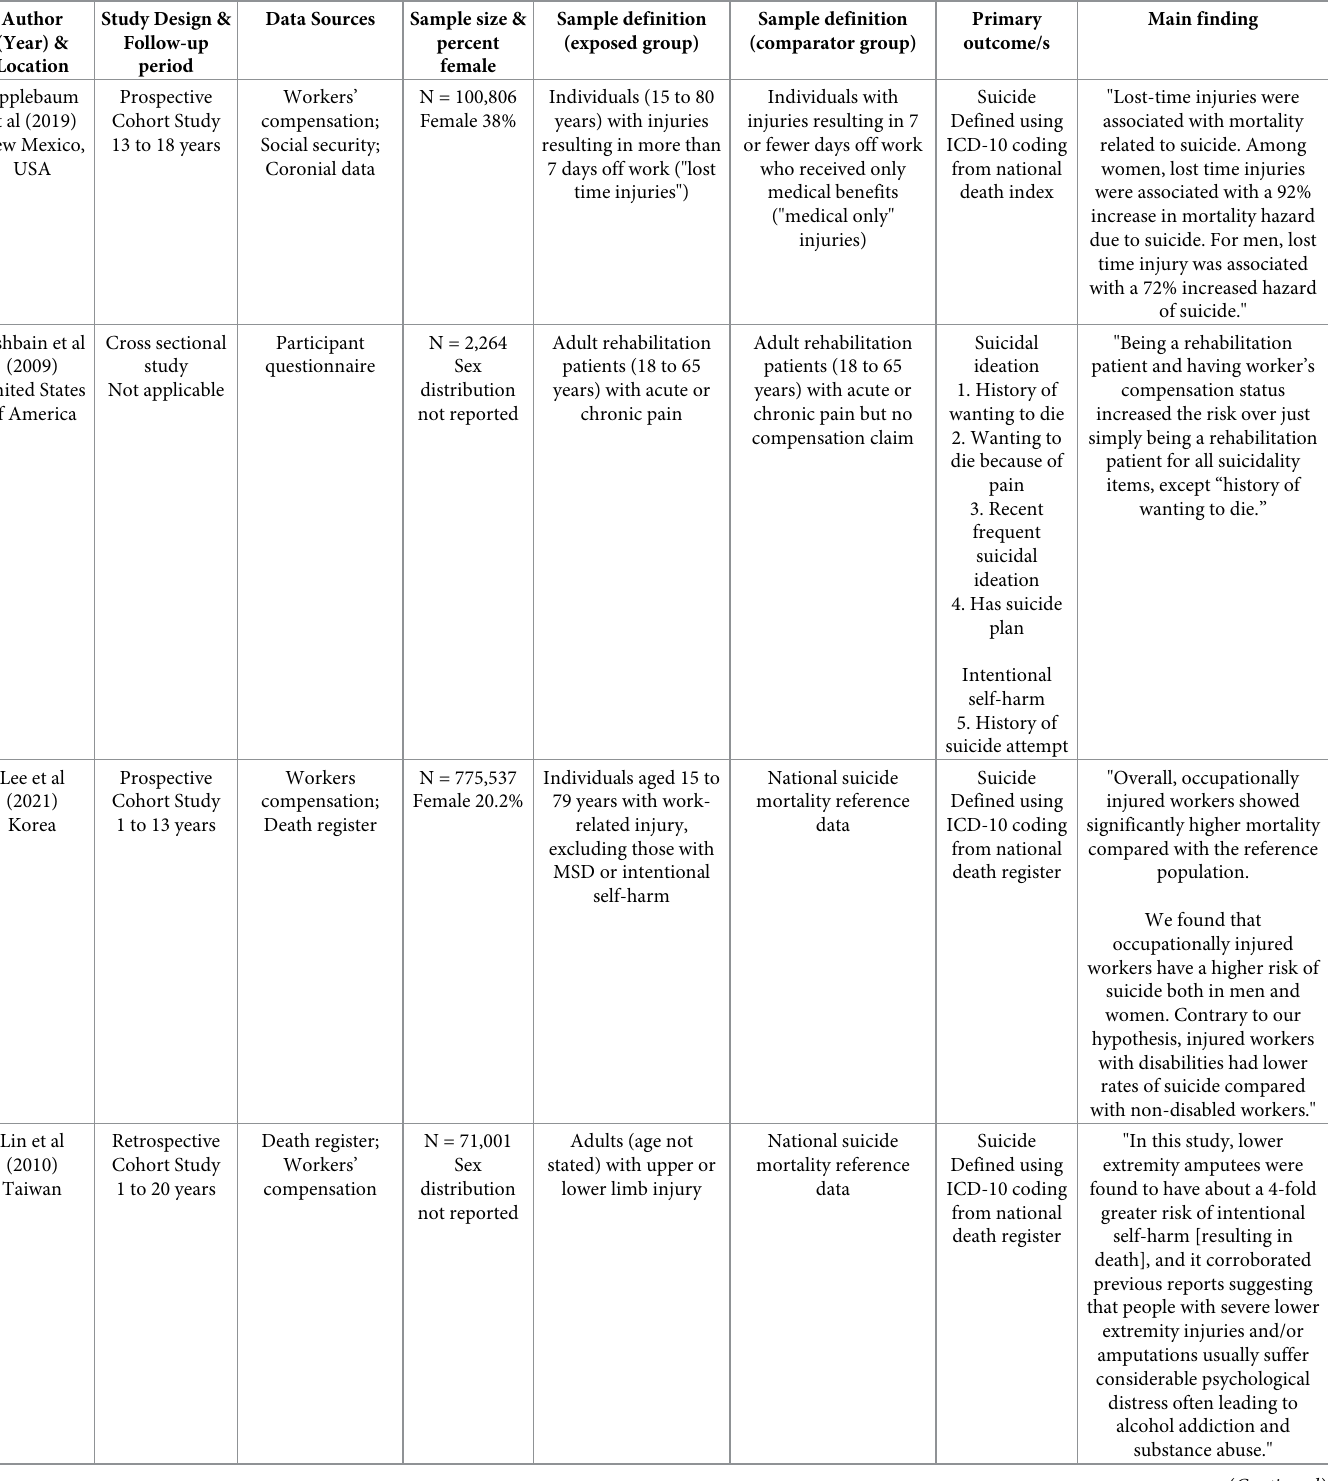
Table 1. Summary of workers’ compensation